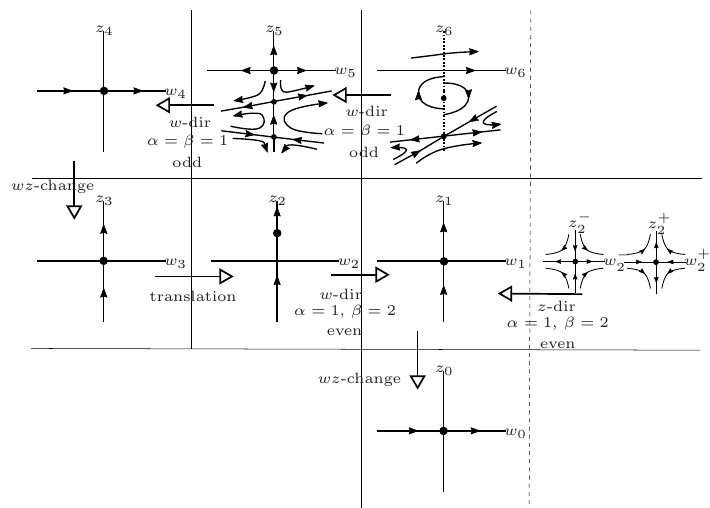
Figure 2 - The sequence of blow downs in the study of the origin of the chart U 1